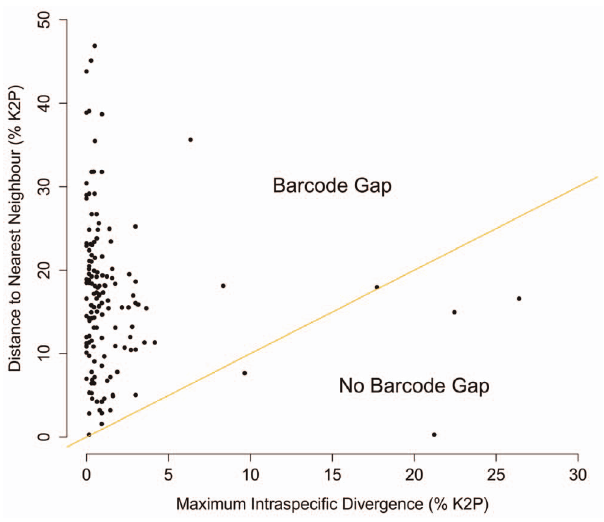
Figure 4. The relationship between COI distance and sample size within genera. Mean nearest neighbour distance (% K2P) at COI plotted against the number of species sampled from each genus of marine mollusc with $ 2 species (N = 50). The regression was insignificant (P=0.052; R 2 =0.08). Morphospecies lacking a generic identification were excluded from analysis. doi:10.1371/journal.pone.0095003.g004 arctica and Macoma balthica derive from Layton 2012) (Figure 6; Figure 7). Variation in nucleotide composition Mean GC content averaged 36.9%, but showed considerable variation (range 24.5%–46.5%). A chi-square test of homogeneity demonstrated significant variation in nucleotide frequencies